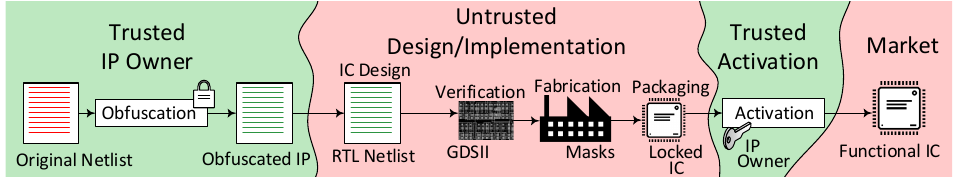
Figure 2: ASIC Design Flow Integrated with